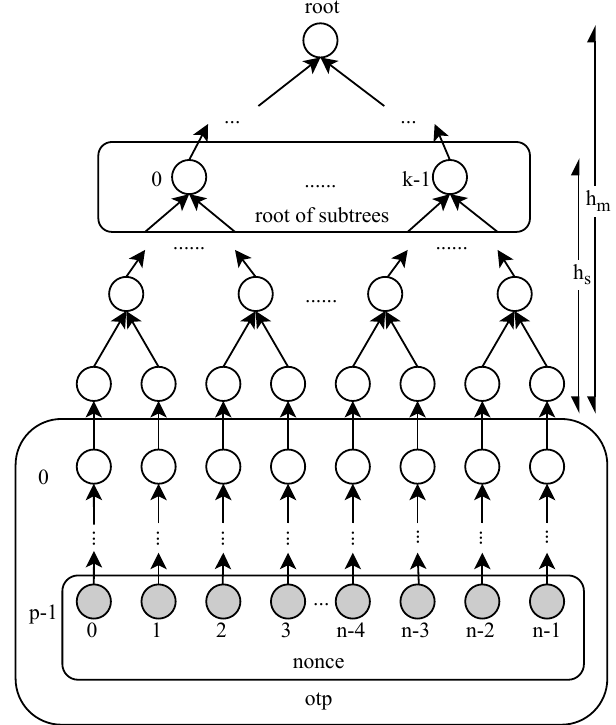
Figure 7. Merkle tree-based One-Time Password (MOTP) data